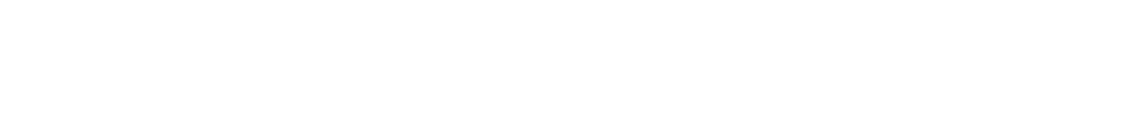
FIGURE 3 | Principle component analysis on metabolite levels. (A) The PCA separation of the genotypes and (B) the loadings of the individual